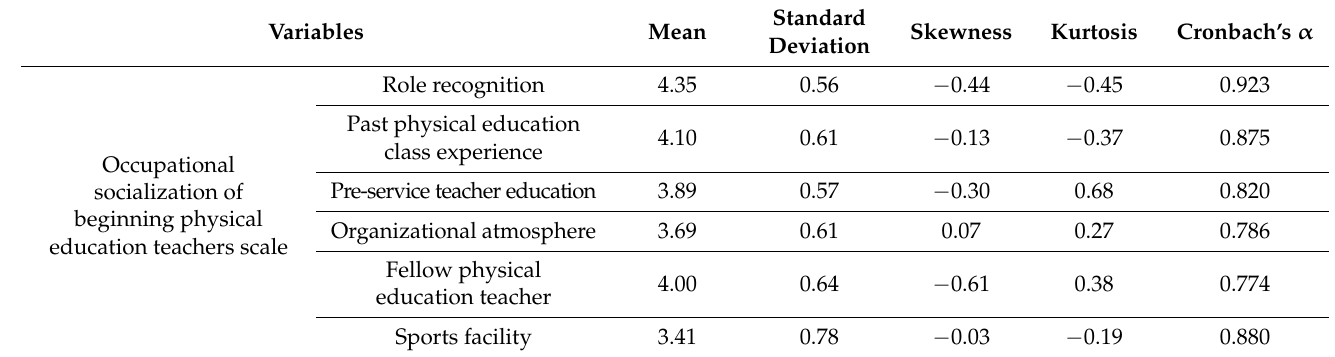
Table 6. Descriptive statistics are based on a five-point Likert response scale and scale